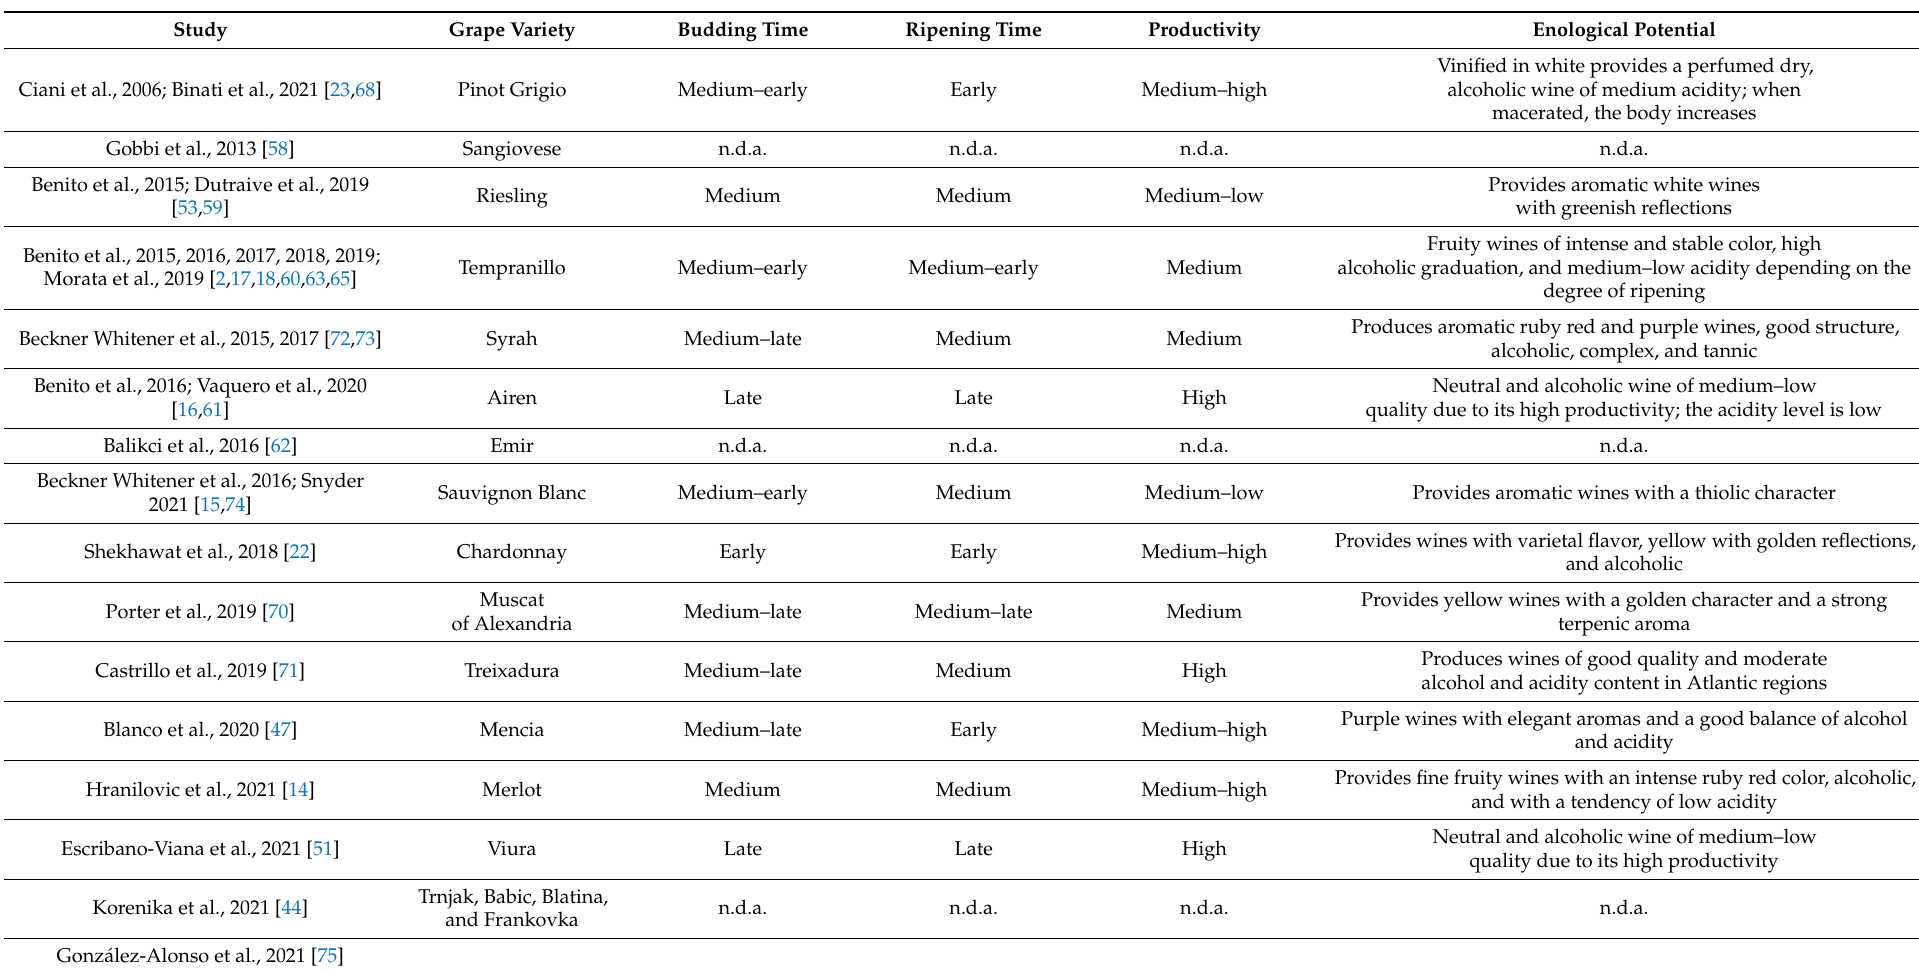
Table 5. Summary of the budding time, ripening time, productivity, and enological potential of grape varieties where Lachancea thermotolerans has been